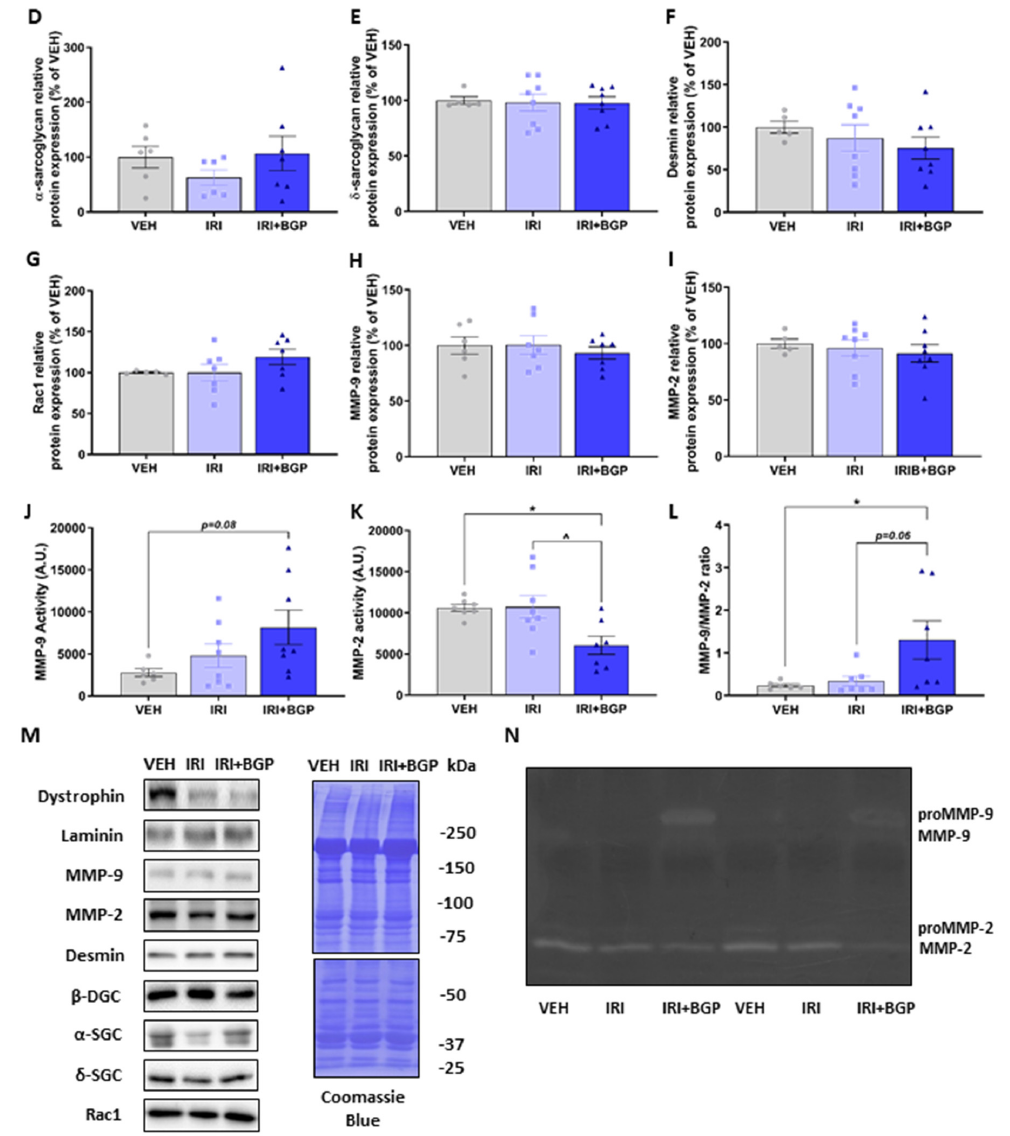
Figure 4. The effect of irinotecan (IRI) and IRI with BGP-15 (IRI+BGP) treatments on molecular markers of sarcolemmal integrity and extracellular matrix (ECM) remodeling. Western blotting experiments were undertaken in tibialis anterior (TA) muscle, with samples probed for ( A ) Laminin, ( B ) Dystrophin, ( C ) β -dystroglycan ( β -DGC), ( D ) α -sarcoglycan ( α -SGC), ( E ) δ -sarcoglycan ( δ -SGC), ( F ) Desmin, ( G ) Rac1 and matrix metalloproteinase (MMP) isoforms ( H ) MMP-9 and ( I ) MMP-2. Gelatin zymography experiments were conducted using extensor digitorum longus (EDL) muscle homogenate (same anterior hindlimb muscle compartment as the TA) to assess the activity of ( J ) MMP-9 and ( K ) MMP-2. ( L ) The ratio of MMP-9 to MMP-2 was utilized to indicate the shift of gelatinolytic MMP activity. Western blotting data are expressed as a relative percentage of the vehicle (VEH) control group and ( M ) representative images are displayed alongside the Coomassie Blue representative image, which was used as the protein loading control. ( N ) Representative image of zymography data is displayed. * = p < 0.05 compared to VEH; ^ = p < 0.05 compared to IRI; n = 5–8.